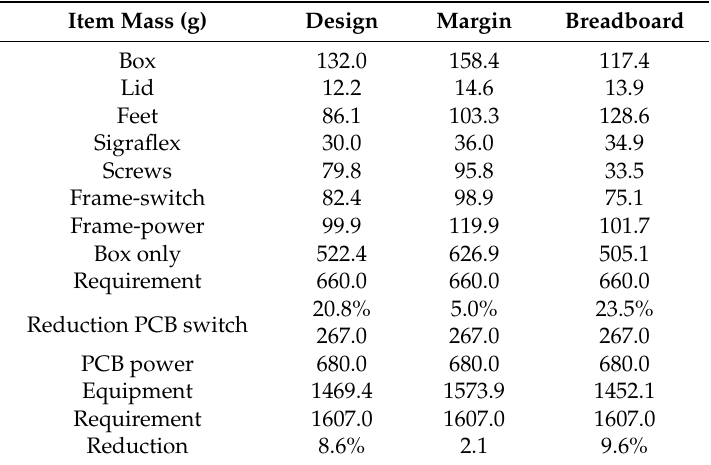
Table 20. Mass budget of breadboard.